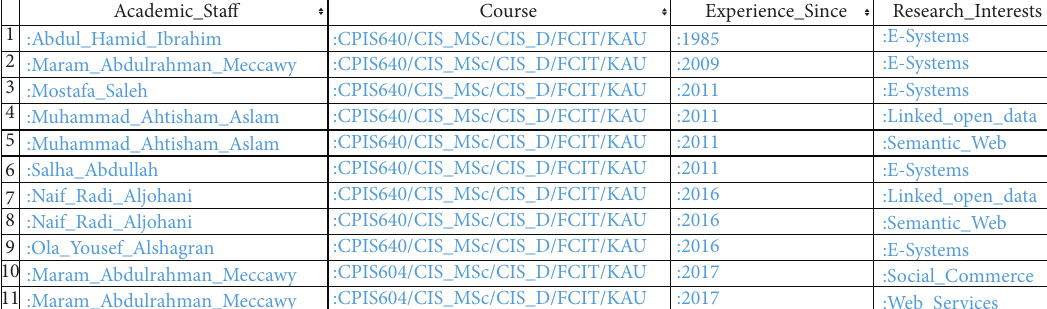
Figure 12: The query result of research interests after criteria.